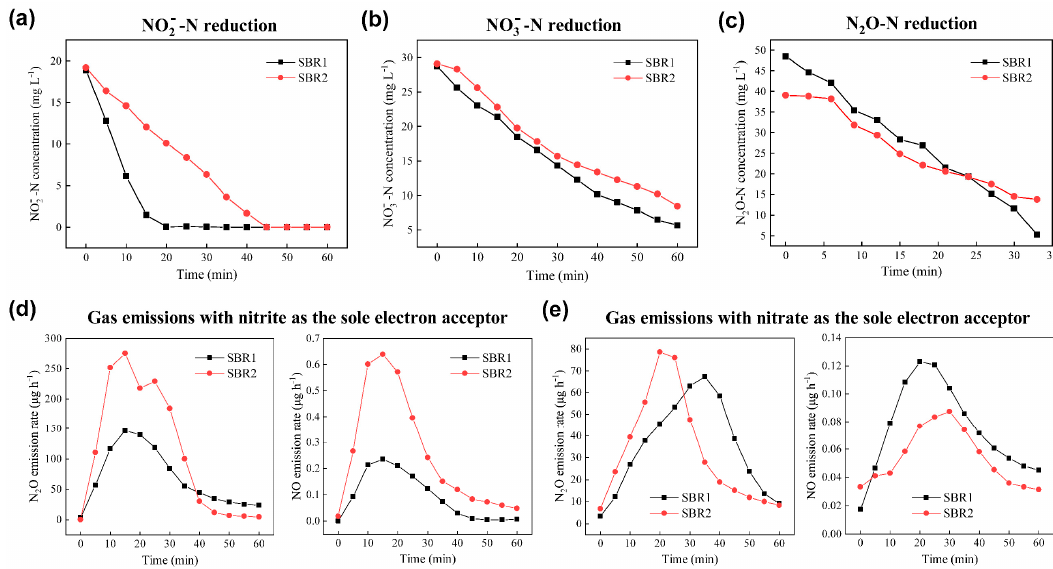
Figure 4. Nitrogen reduction ( a – c ) and N 2 O/NO emission rates ( d , e ) under different electron acceptors (NO − -N, NO − -N and N 2 O-N) utilized in batch experiments. 2 3 For both reactors, the calculated N 2 O/NO emission amounts (SBR1:71.84/0.098 μ g; SBR2:118.84/0.270 μ g) when using NO − -N were also far larger than those 2 (SBR1:37.19/0.078 μ g; SBR2:34.30/0.056 μ g) when using NO − -N as the sole electron accep- 3